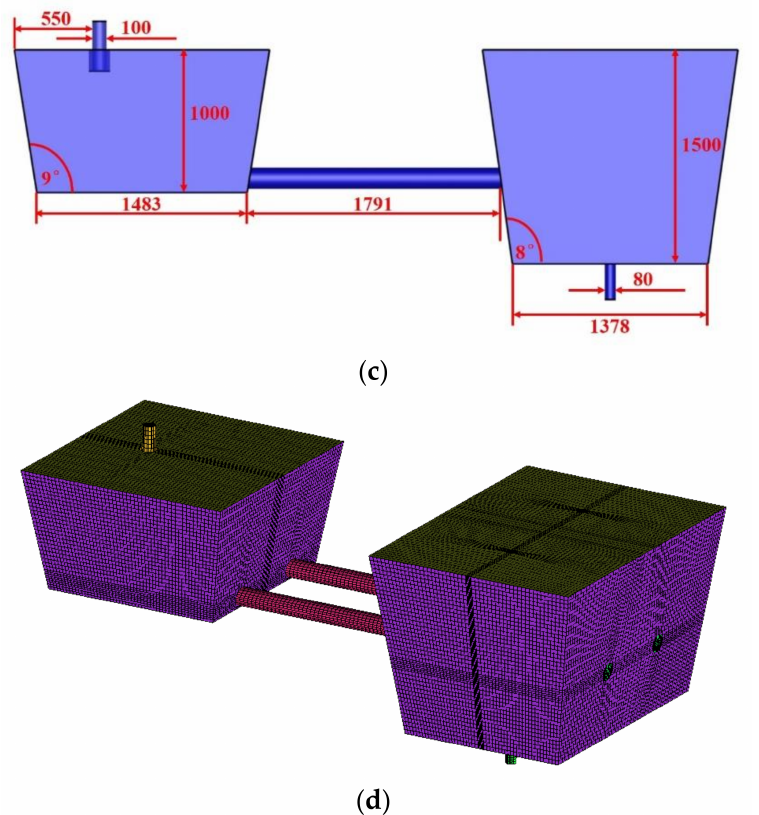
Figure 1. Tundish with channel induction heating (all dimensions are in mm). ( a ) Tundish model; ( b ) top view; ( c ) front view; ( d ) mesh of tundish. Table 1. The operating parameters, geometry parameters and physical parameters of computa- tional models. Parameters Value Units Strands